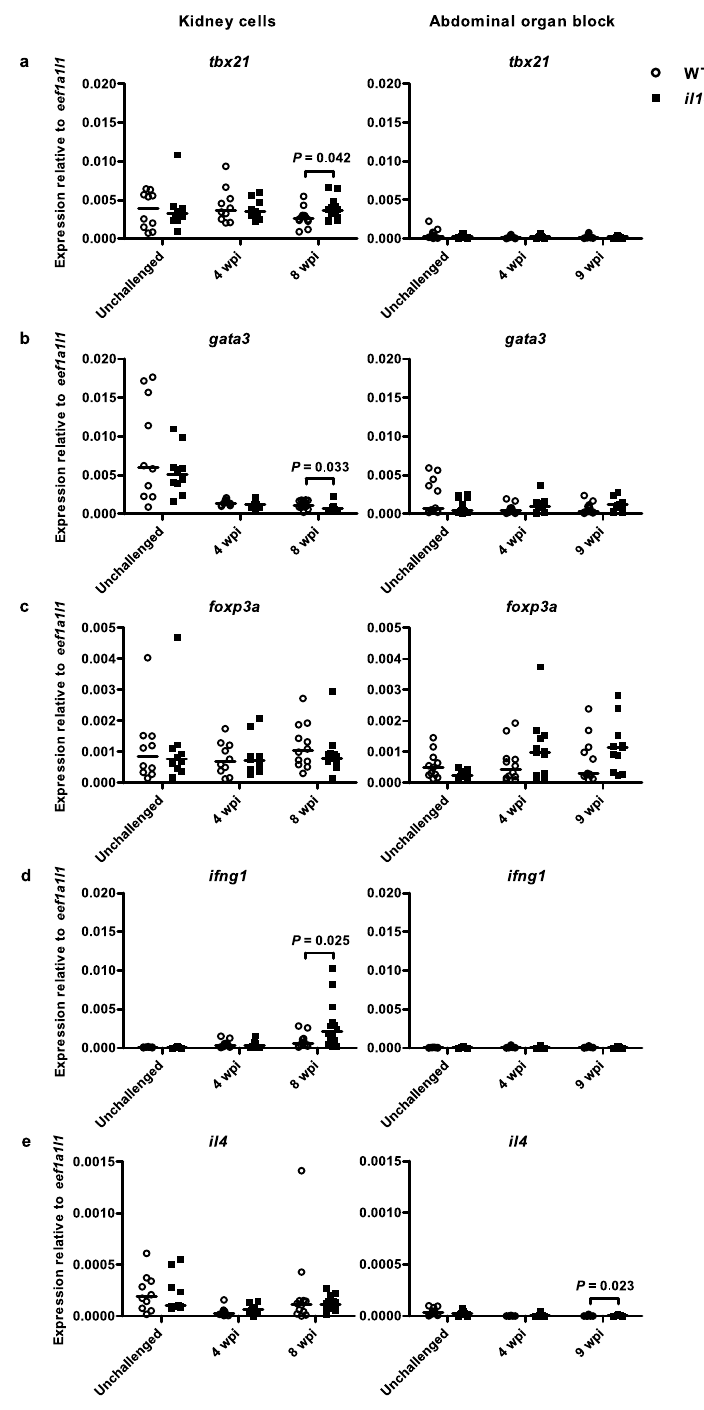
Figure 7. il10 e46/e46 mutant zebrafish have an enhanced Th1 cell mediated immune response in a mycobacterial infection. ( a – e ) The relative expressions of Cd4 + lymphocyte transcription factors ( tbx21 , gata3 , foxp3a ) and Th cell cytokines ( ifng1 and il4 ) in kidneys of unchallenged il10 e46/e46 mutants ( n = 10) and WT control fish ( n = 10) and in the unsorted kidney cell populations of il10 e46/e46 mutants ( n = 10–14) and WT control fish ( n = 10–12) at 4 and 8 weeks post a low-dose (1–18 CFU) infection (on the left) as well as in the abdominal organ blocks (including kidney) of unchallenged il10 e46/e46 mutants ( n = 12) and WT control fish ( n = 11–12) and at 4 and 9 weeks post a low-dose (2–9 CFU) infection ( n = 12 and n = 12, respectively) (on the right) were measured with qPCR. Data are presented as a scatter dot plot and median. Gene expressions were normalized to the expression of eef1a1l1 . Each dataset was collected from a single experiment. A two-tailed Mann-Whitney was used for the statistical comparison of